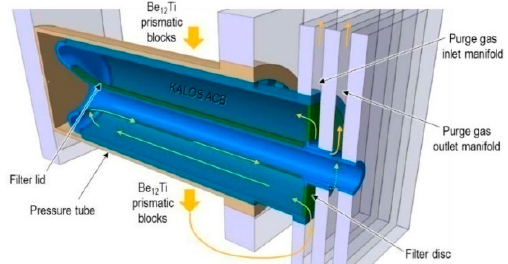
Figure 1. DEMO helium-cooled pebble bed (HCPB) fuel pin with purge gas loop.